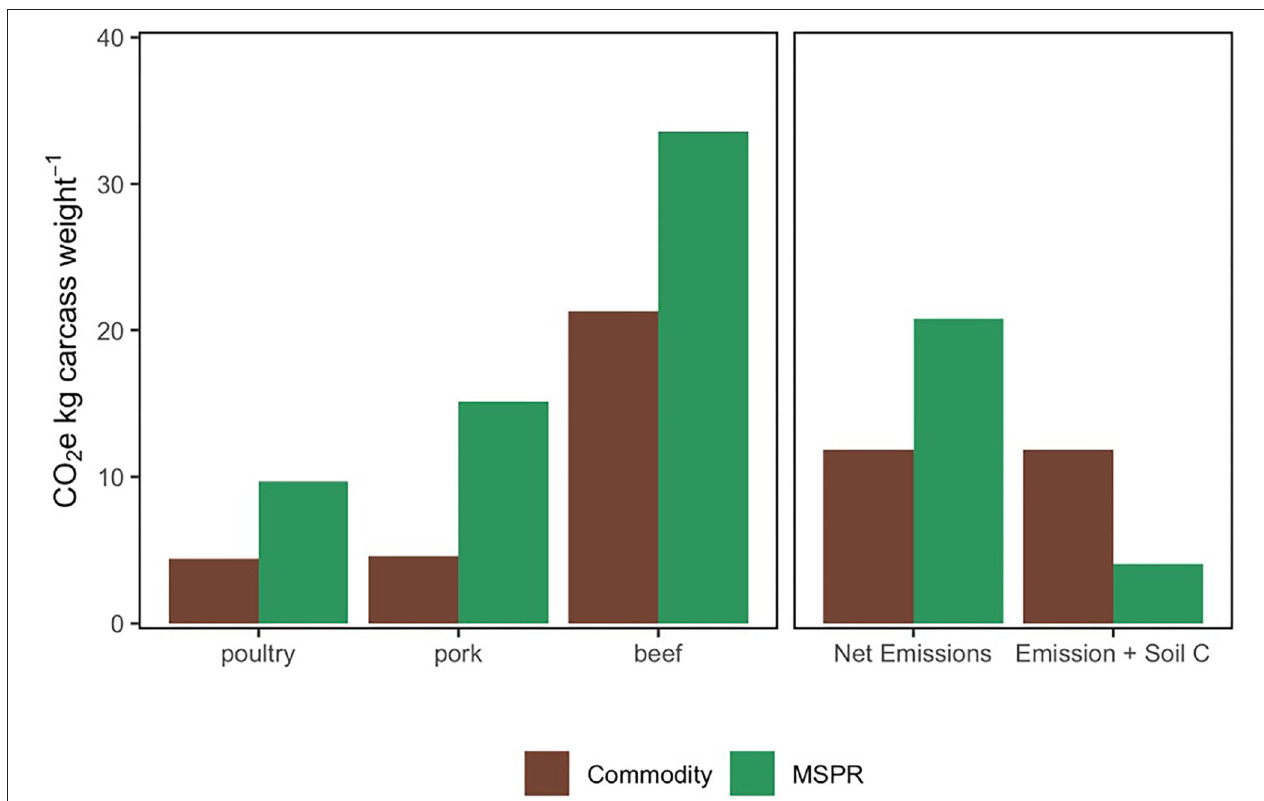
FIGURE 3 | Comparison of a Commodity and Multi-Species Pasture Rotation (MSPR) CO 2 -e on a kg CW basis by specie (left) and then aggregated for the mean overall net farm emission with and without soil C sequestration